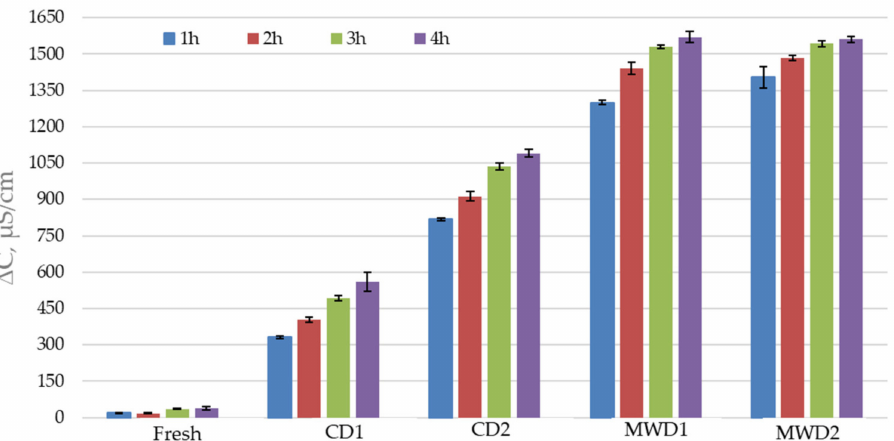
Figure 3. Electrolyte losses from fresh and dried basil samples (CD1—shade drying conditions; CD2—hot air-drying; MWD1—assisted microwave heating 2300 W; MWD2—assisted microwave heating 1150